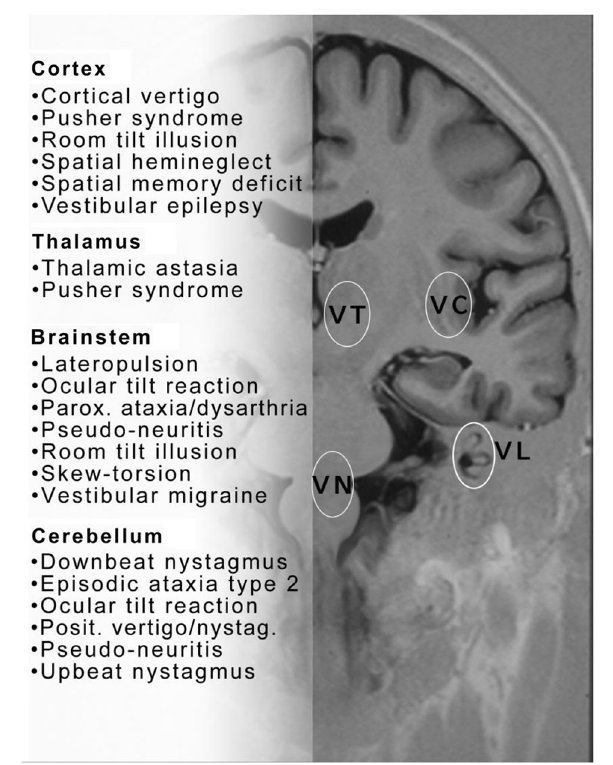
FIGURE 1 | This figure proposes a collection of clinical syndromes which may be called central vestibular disorders or disorders of higher vestibular function . They are depicted in alphabetical order and topographically grouped for cerebral cortex, thalamus, brainstem and cerebellum. The topographic assignment remains uncertain for some conditions. Note also that similar disorders occur with lesions at different sites—brainstem or cortex (room tilt illusion) or brainstem and cerebellum ocular tilt reaction (OTR)—within the central vestibular neuronal circuitry. Please note that this list does not include all central vestibular syndromes. VC = vestibular cortex; VT = vestibular thalamus; VN = vestibular nucleus; VL = vestibular